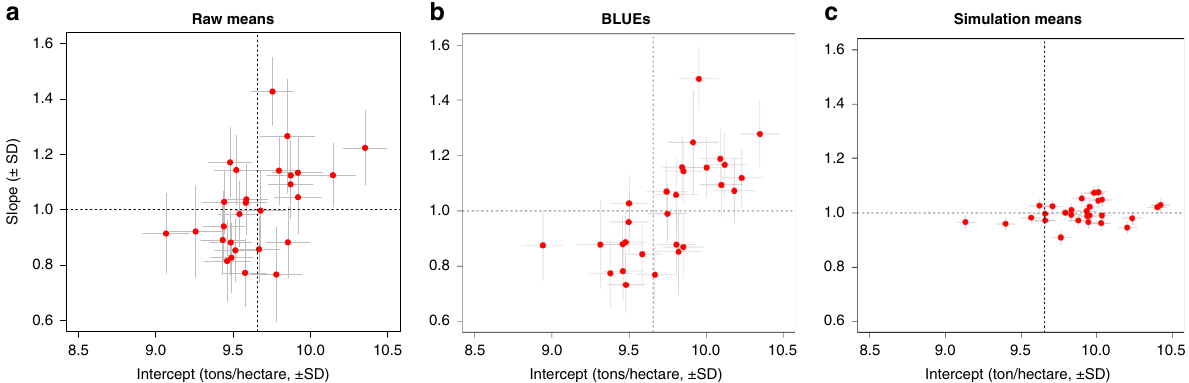
Fig. 7 Finlay – Wilkinson coef fi cients. Coef fi cients were derived from the raw genotype-by-location means ( a ), BLUEs ( b ) and simulated genotype-by- location means averaged over 16 years of historical weather data ( c ). Vertical and horizontal lines, represent intervals de fi ned as mean + / −